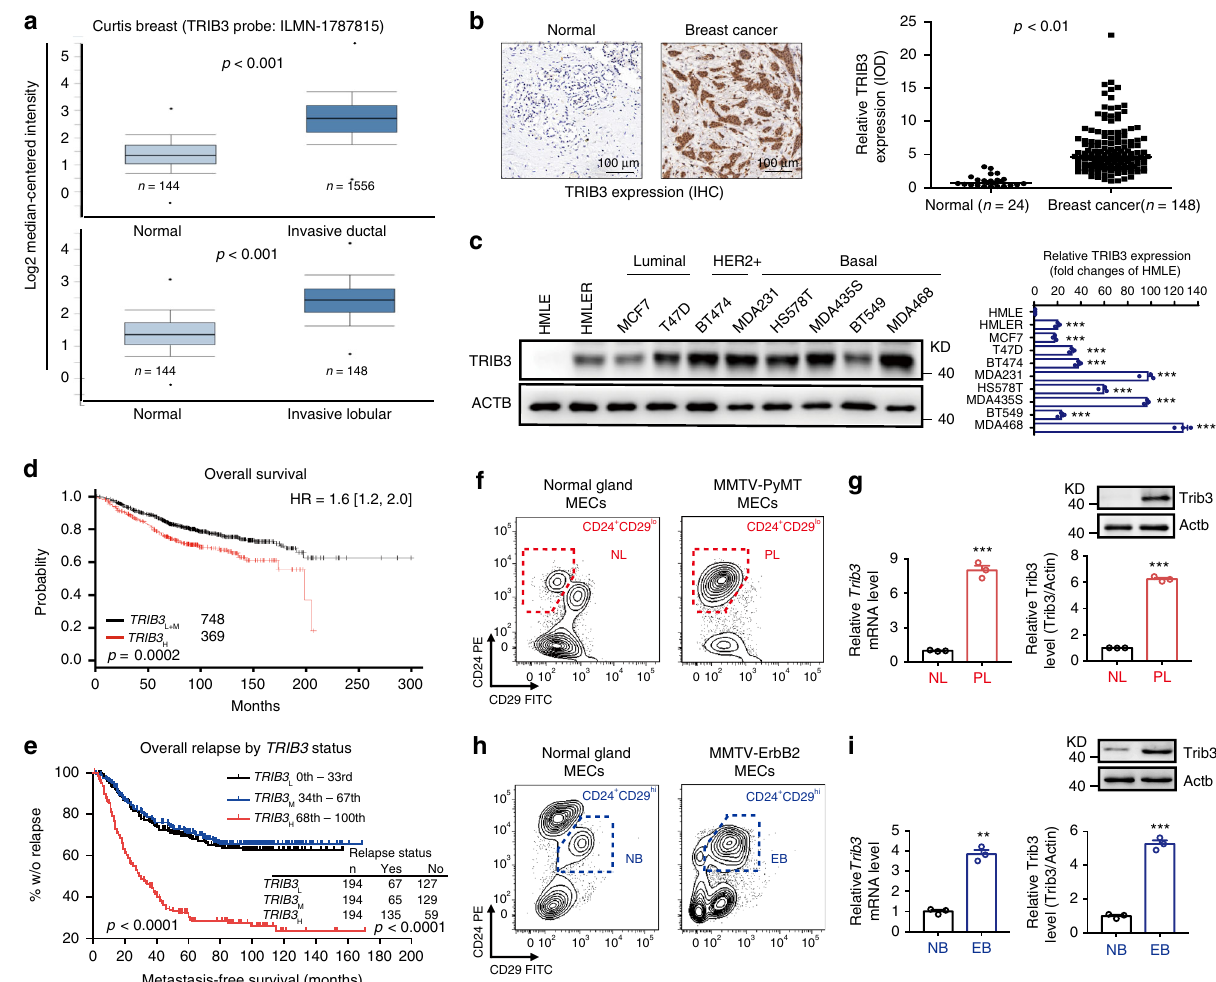
Fig. 1 High TRIB3 expression is negatively associated with overall survival and metastasis-free survival in breast cancer. a Graph derived from published data available in the Oncomine database. The box charts depict the relative expression of TRIB3 in invasive ductal (top) and invasive lobular (bottom) breast cancer patients. Centre line = 50th percentiles; bounds of box = 25th and 75th percentiles; bars = 10th and 90th percentiles; whiskers = min and max values. b Formalin- fi xed, paraf fi n-embedded tissue microarray sections of normal and breast cancer tissues were stained with an anti-TRIB3 antibody. Tissue-bound TRIB3 is shown in brown (left). The dot plots show the relative expression of TRIB3 calculated by the intensity of the brown color in tissue array immunohistological images (right). c Immunoblots of protein lysates from HMLE, HMLER, and BCCs, as indicated at the top of the left panel. The relative TRIB3 expression quanti fi cation from three independent studies is shown (right). d , e Graph derived from TCGA ( d ) or published data ( e ) available in the PubMed GEO database (GSE2603, GSE5327, GSE2034, and GSE12276). For each analysis, 1117 patients ( d ) or 582 patients ( e ) were segregated into tertiles, with the group designated TRIB3 H representing one-third of the patients who had tumors with the highest levels of TRIB3 mRNA and the group designated TRIB3 L representing one-third of patients who had cancers with the lowest levels of TRIB3 mRNA. One-third of patients who had tumors with intermediate TRIB3 mRNA expression were designated as TRIB3 M . Overall survival ( d ) and metastasis-free survival ( e ) were determined by Kaplan – Meier analyses, and signi fi cant differences were determined by the log-rank test. The number of patients in each category, the total